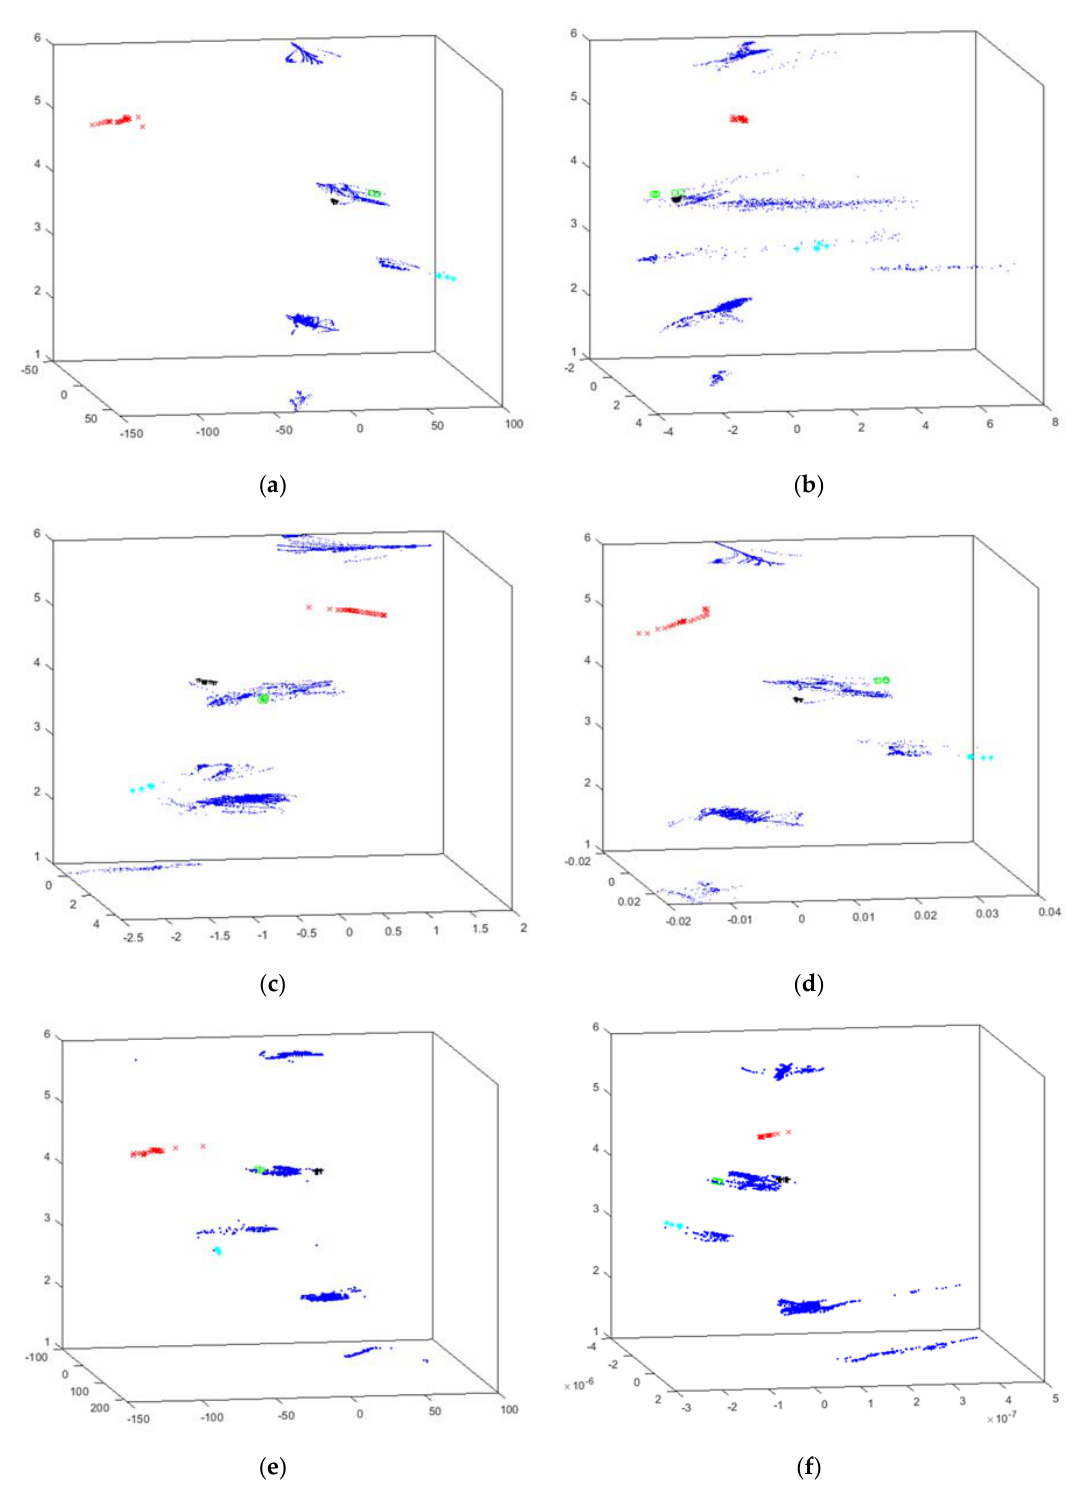
Figure 5. HUEP visualizations of the intensifier dataset. EPP+hierarchical clustering. ( a ) HUEP: PCA+hierarchical clustering ( k = 6, Cityblock, and complete). ( b ) HUEP: MLHL+hierarchical clustering ( k = 6, Cityblock, and complete). ( c ) HUEP: CMLHL+hierarchical clustering ( k = 6, Cityblock, and complete). ( d ) HUEP: CMDS–cityblock+hierarchical clustering ( k = 6, Cityblock, and complete). ( e ) HUEP: SM+hierarchical clustering ( k = 6, Cityblock, and complete). ( f ) HUEP: FA+hierarchical clustering ( k = 6, Cityblock, and complete).